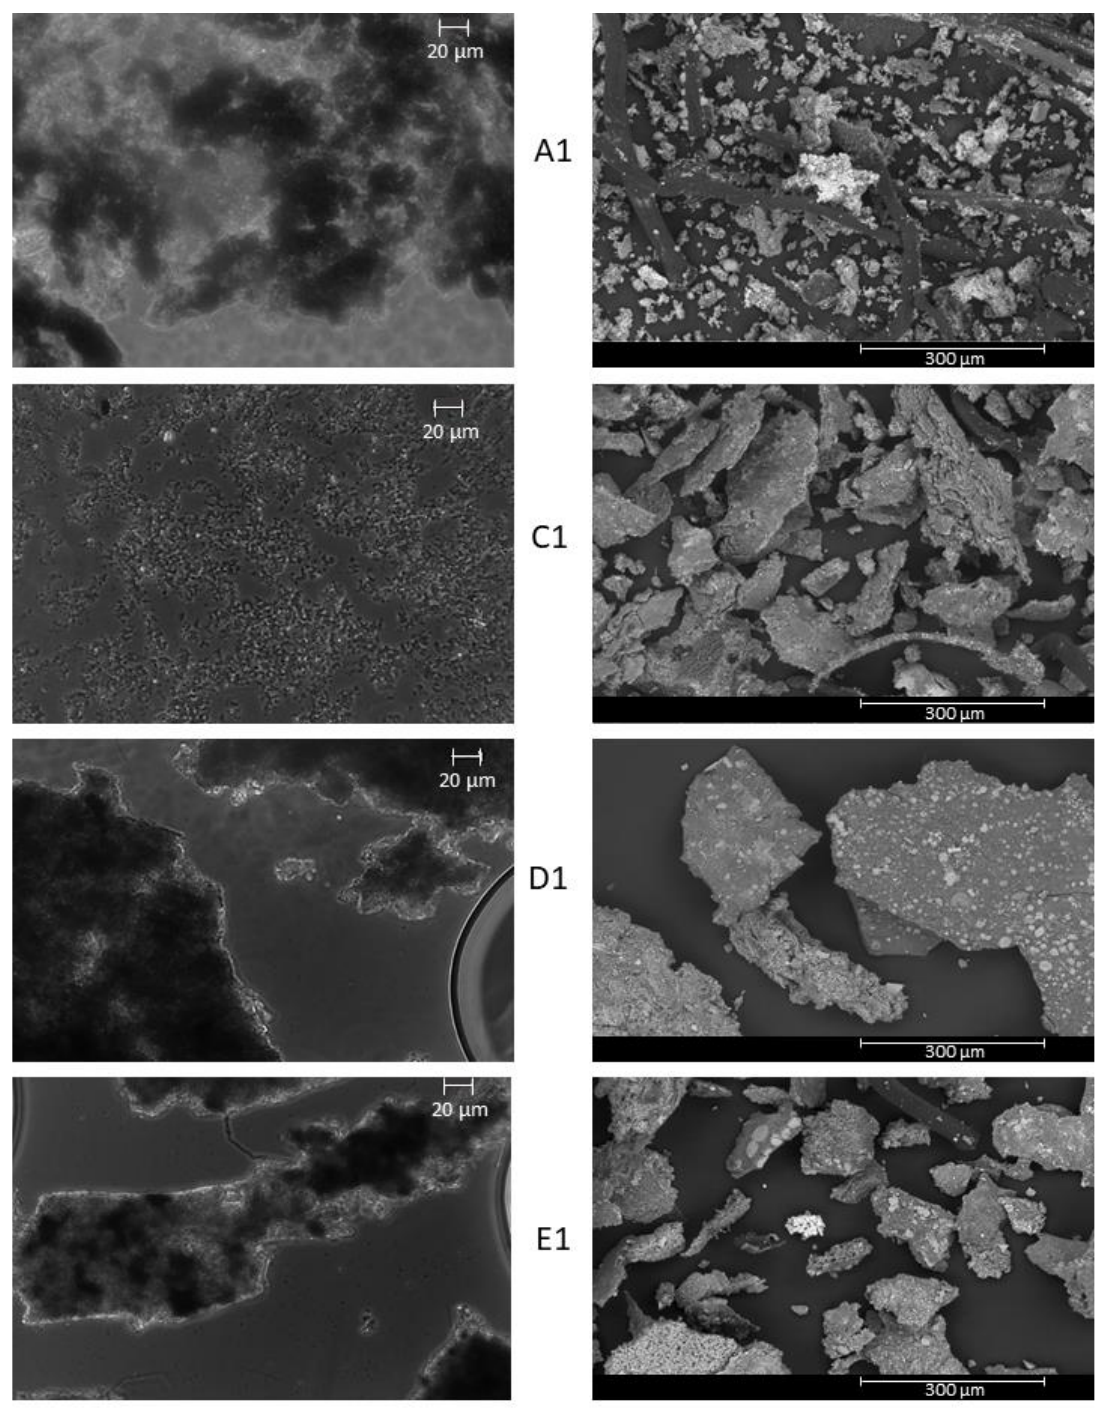
Figure 8. Microscope pictures (top) and SEM pictures (bottom) of particulate material collected over the water trajectory through the study system at locations A1, C1, D1 and E1.